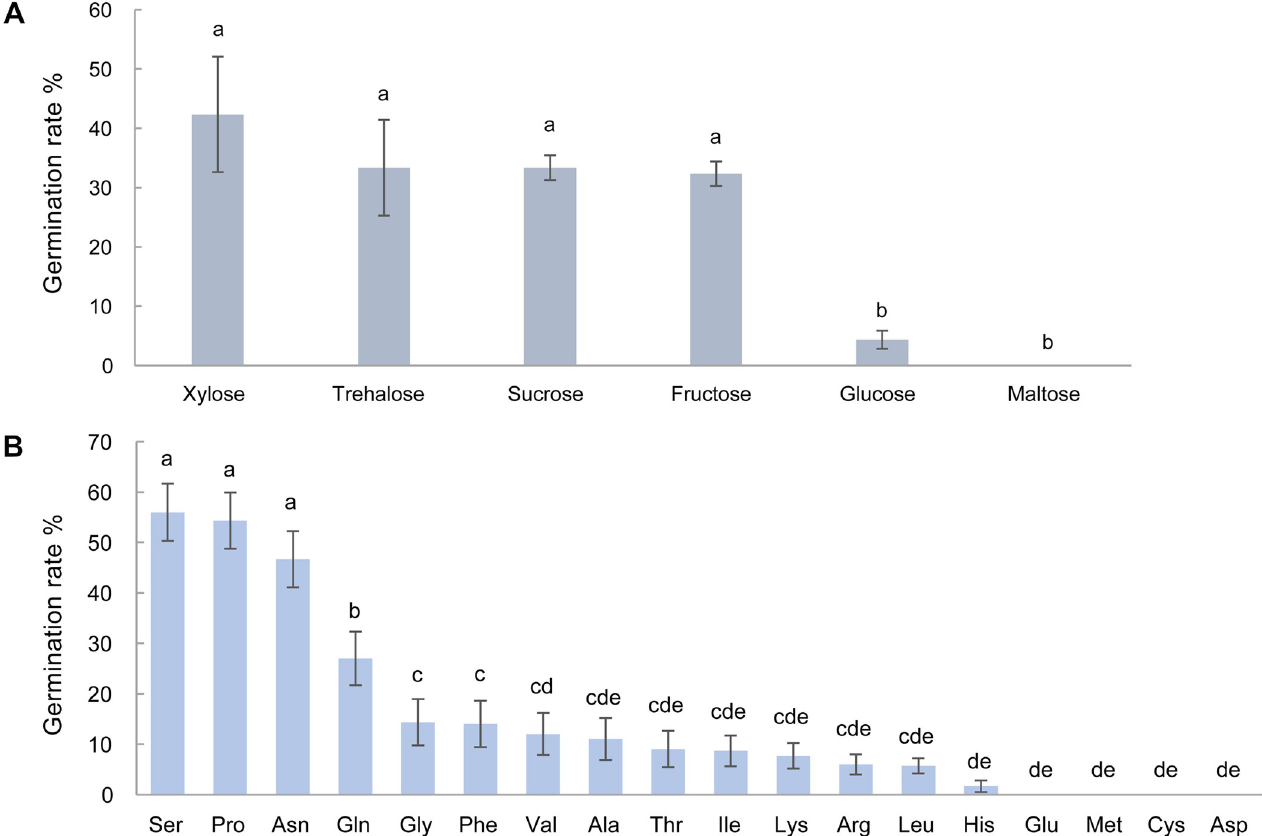
Fig 8. Germination rates of P . brassicae resting spores incubated with various sugars (A) and L-amino acids (B) in the presence of nitrate. Non-sterile spores were incubated with 50 mM potassium nitrate for 14 days. The germination rate in the water control was 0%. Error bars indicate standard deviations. Different letters indicate significant differences among samples (Tukey test, P < 0.05, n =